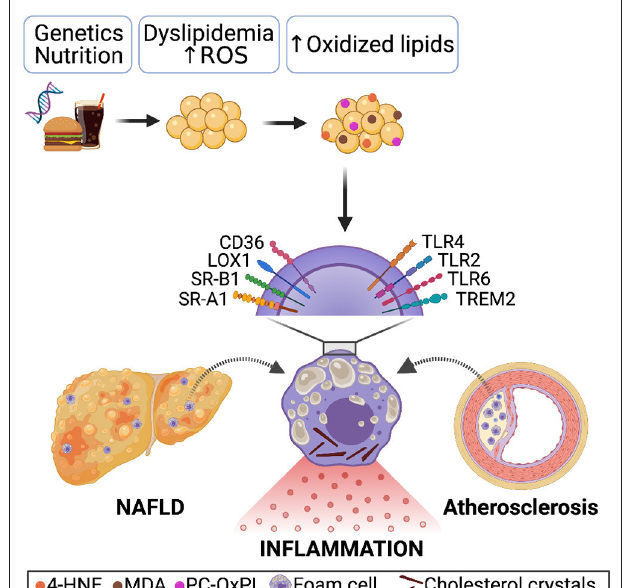
FIGURE 1 | Genetics, sedentary lifestyle and/or unhealthy nutrition causes systemic dyslipidemia characterized by increased LDL levels. Due to oxidative stress and ROS production, oxidation-specific epitopes present on oxidized lipids, dying cells, and microvesicles accumulate. Receptor-mediated recognition and uptake of oxidized lipoproteins by macrophages in the steatotic liver and atherosclerotic plaque results in a foamy appearance, lysosomal dysfunction, and cholesterol crystals formation, causing pro-inflammatory signaling and thereby enhancing disease progression.